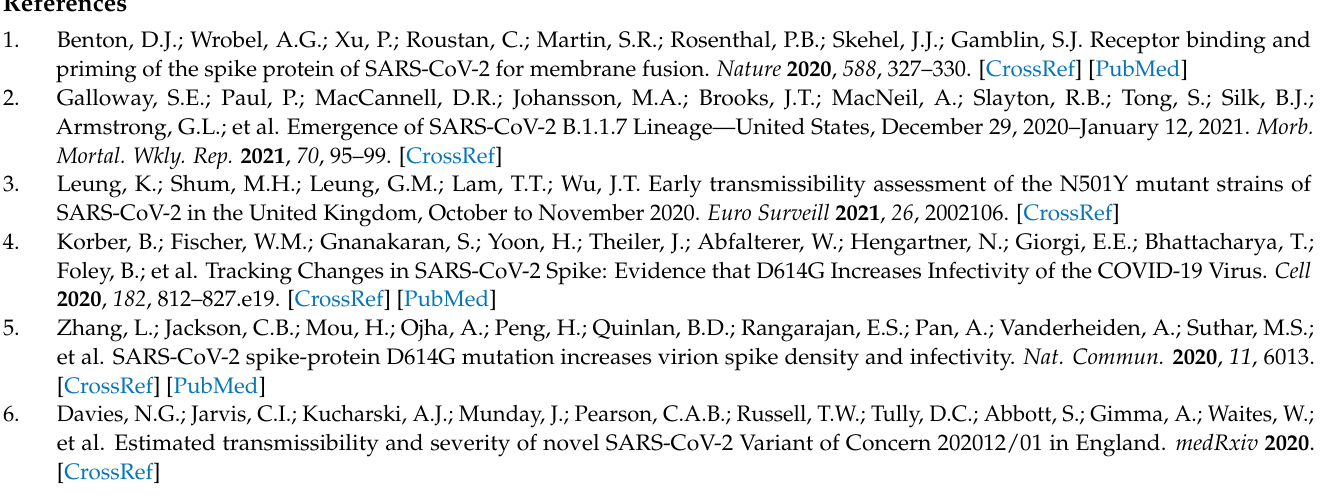
on the viral surface, Figure S2: Differences of RMSF values between wt and B.1.1.7 spike protein residues, Figure S3: Results of the wt+D614G variant and RMSD values the receptor-binding domain (RBD), Figure S4: Structural flexibility of the receptor-binding domain-ACE2 (RBD–ACE2) complex, Figure S5: Analysis of the interface between ACE2 and the receptor-binding domain (RBD), Figure S6: Interaction energies of the MM/GBSA analyses for the wild type and the B.1.1.7 receptor-binding domain (RBD) variants complexed with ACE2, Figure S7: Individual intermolecular contact plots for all four molecular dynamics (MD) simulation runs of the wild type RBD–ACE2 complex, Figure S8: Individual intermolecular contact plots for all four molecular dynamics (MD) simulation runs of the B.1.1.7 RBD–ACE2 complex, Figure S9: Electrostatic affinity shown on the RBD–ACE2 interface for ACE2 residues, Figure S10: Van der Waals linear interaction energy shown on the RBD–ACE2 interface for ACE2 residues, Table S1: Statistical analysis of RMSF plots from wt and B.1.1.7 spike protein residues 26-300, Table S2: Statistical analysis of RMSF plots from wt and B.1.1.7 spike protein residues 800-900, Table S3: Statistical analysis of contacts between residues from the receptor binding domain and ACE2 from wt and B.1.1.7, Table S4: Statistical analysis of electrostatic interaction energy of residues from the receptor binding domain comparing wt and B.1.1.7, Table S5: Statistical analysis of electrostatic interaction energy of residues from ACE2 comparing wt and B.1.1.7, Table S6: Statistical analysis of van der Waals interaction energy of residues from the receptor binding domain comparing wt and B.1.1.7, Table S7: Statistical analysis of electrostatic interaction energy of residues from ACE2 comparing wt and